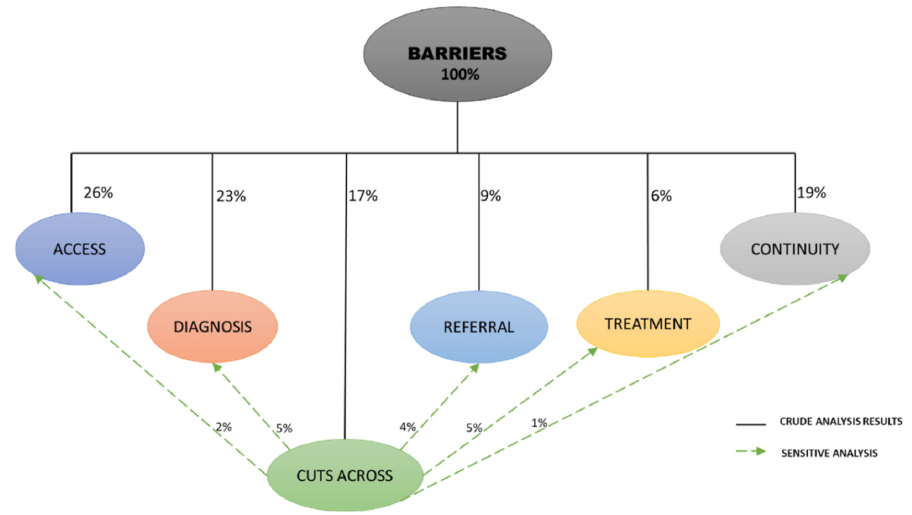
Figure 3. Mapping the proportion of barriers within lung cancer care continuum (Phase 1).